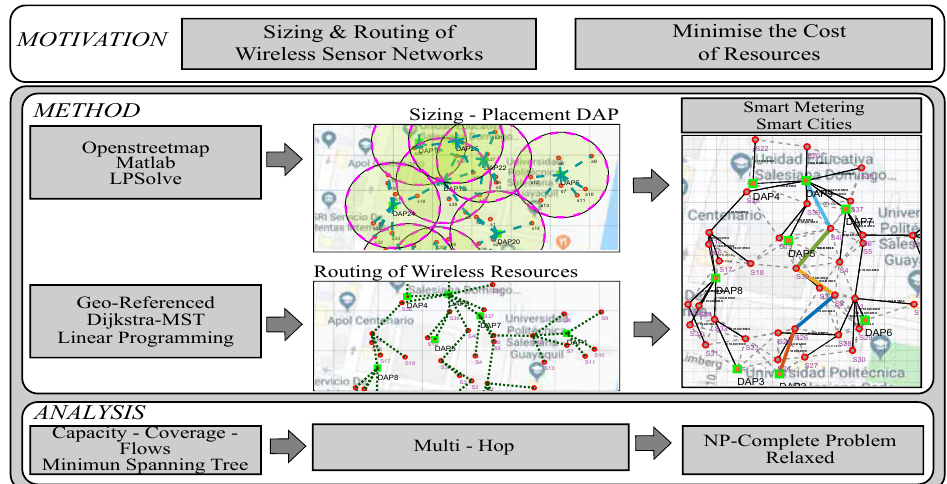
Figure 1. Geo-referenced sizing and routing of wireless sensor